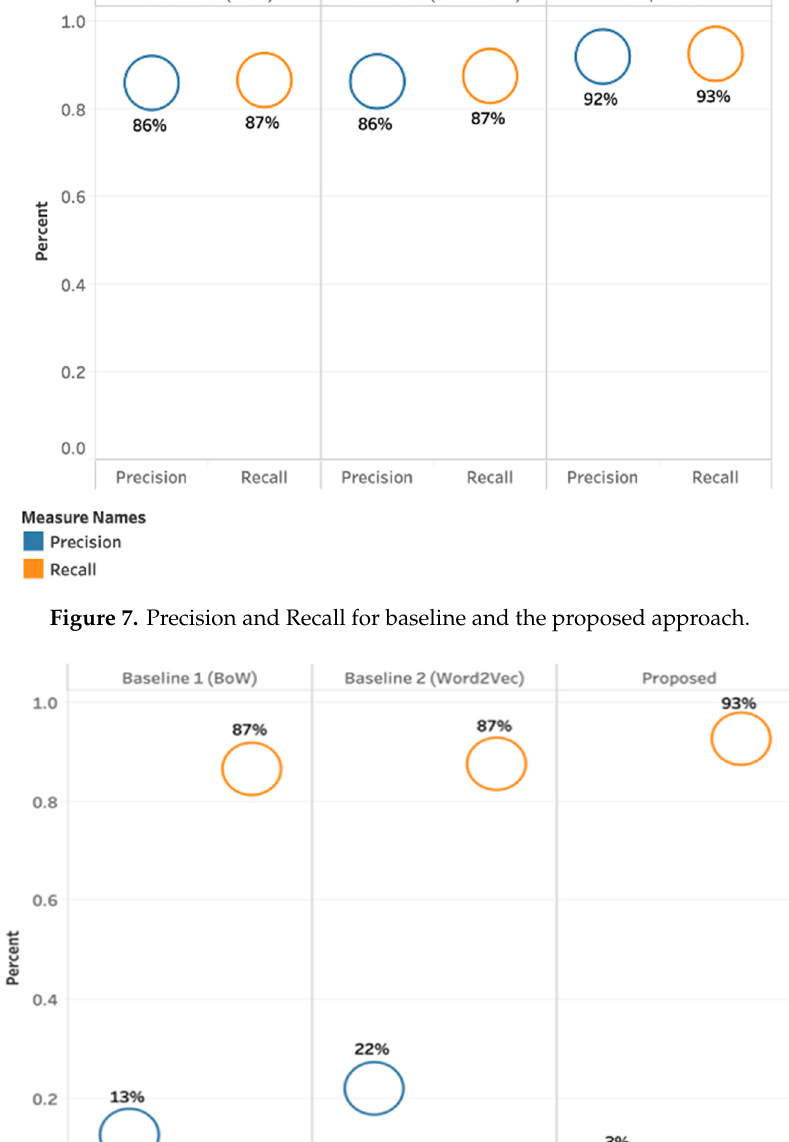
Figure 6. Comparison of baseline approach with the proposed approach.